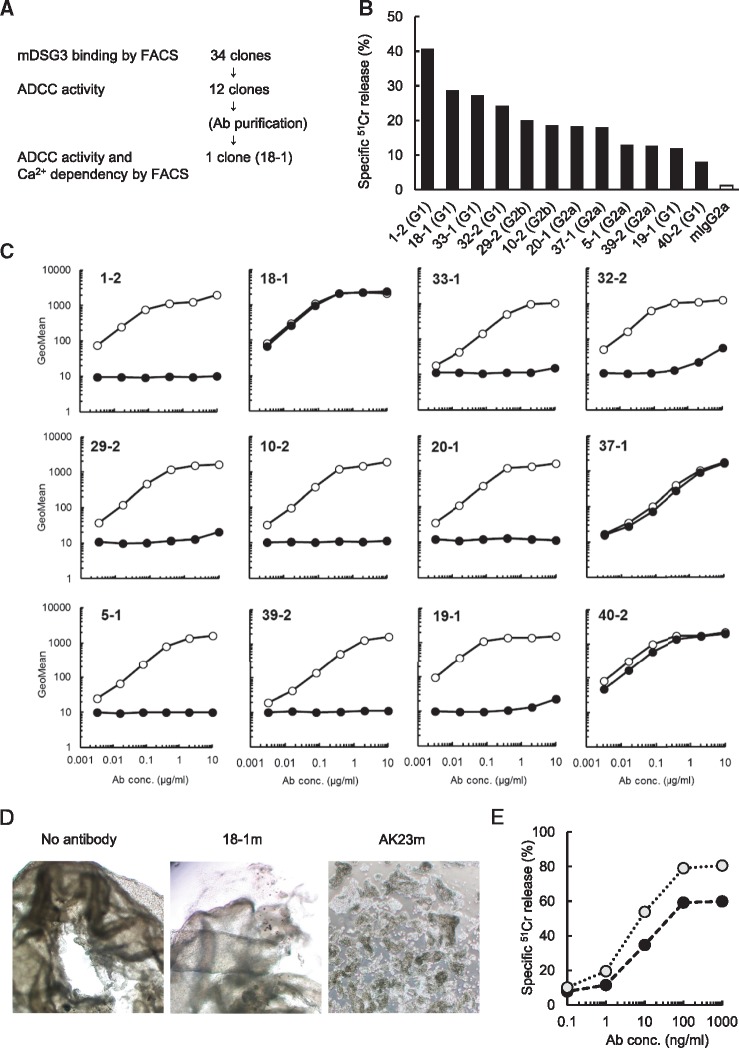

Characterization of anti-mouse DSG3 mAbs. (A) Screening flow for an anti-mouse DSG3 mAb. (B) Analysis of ADCC activity. 51Cr-labelled 1 × 104 mouse DSG3/BaF3 cells were incubated with hybridoma supernatant at 1 μg/ml antibody for 15 min. mFcγRIIIa-NK92 were added at E/T ratio = 5:1 and the cell suspensions were further incubated at 37°C for 4 h. The radioactivity was measured with Gamma counter. Specific 51Cr release was calculated. Mouse IgG2a was used as reference control. (C) Analysis of Ca2+-dependent binding activity to mouse DSG3. Serial diluted mAbs were incubated with mouse DSG3/DG44. The binding activity to mouse DSG3 was measured with FACS with EDTA (closed circle) or without EDTA (open circle). (D) Analysis of cell–cell dissociating activity with mouse IgG2a type chimeric anti-DSG3 18-1m. Cell–cell dissociating activity with mAb 18-1m was analysed by keratinocyte dissociation assay (27). mAb AK23m was used as positive control. (E) ADCC enhancement by defucosylated chimeric anti-DSG3. ADCC activity of 18-1m was compared. Mouse DSG3/DG44 was incubated with serial diluted antibody and mixed with mFcγRIIIa-NK92 as effector cells. ADCC activity was measured. Black circle: 18-1m, grey circle: df-18-1m prepared with GFT (-/-) CHO cells.